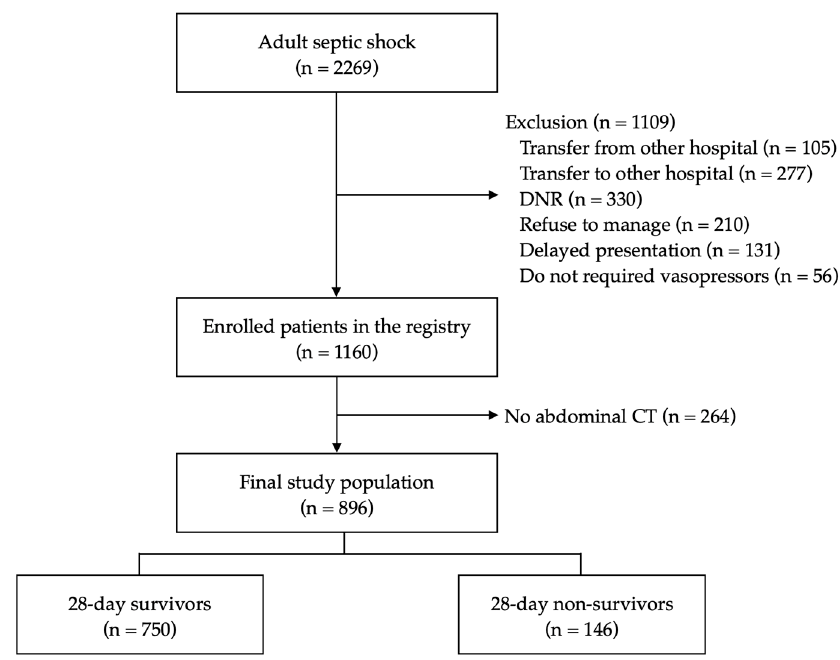
Figure 2. Flowchart of patient enrollment and allocation in the study. DNR, do-not-resuscitation; CT, computed tomography.